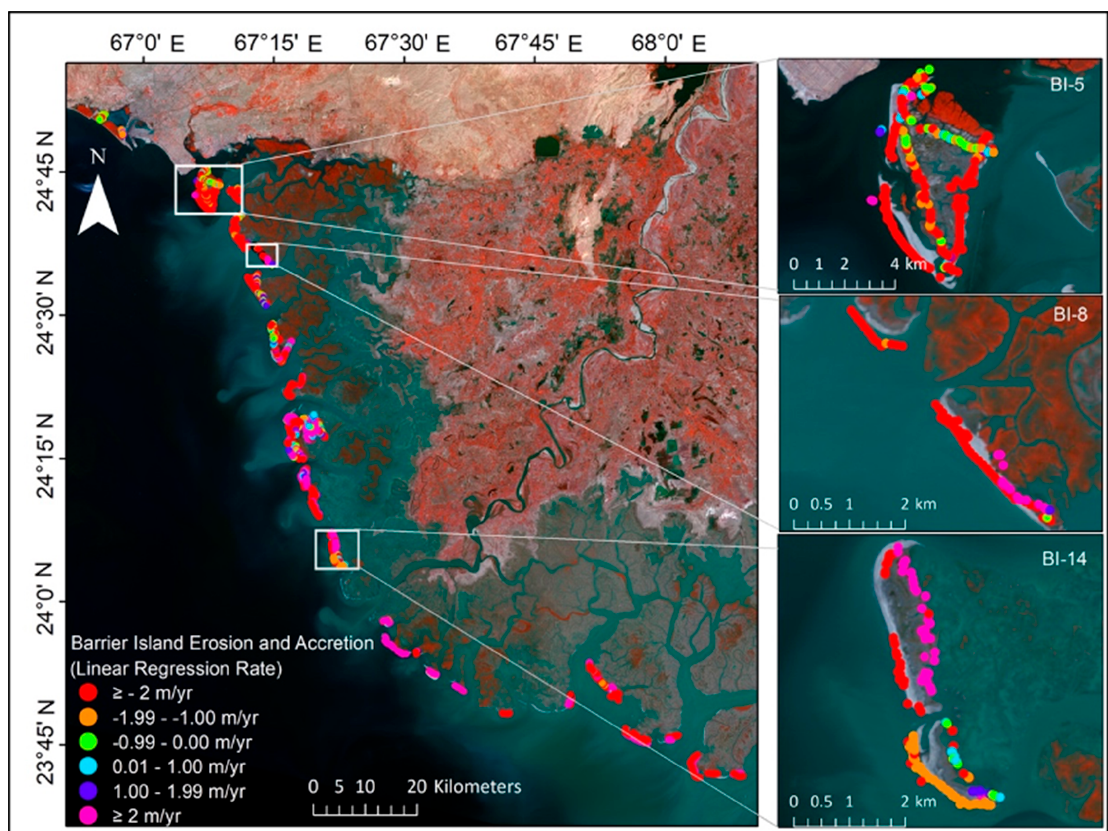
Figure 6. Map of BI perimeter change rate distribution along the Sindh coast. Insets show enlarged views of islands 5, 8, and 14. Areas with higher erosion rates and areas that have accreted are divided into sub-classes and represented in different colors. Positive values represent accretion and negative values represent erosion.